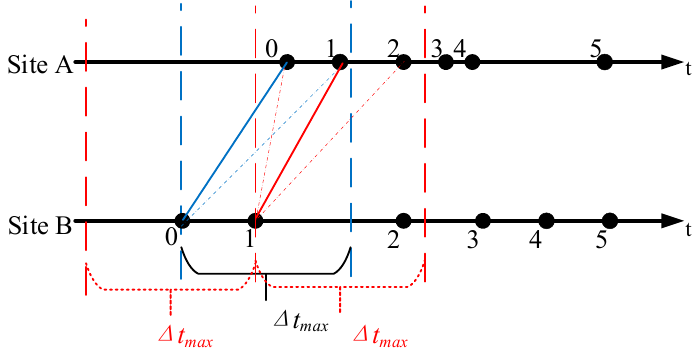
Figure 2. The schematic diagram of the radiation point matching algorithm.